Question: Give a one-sentence summary of this figure.
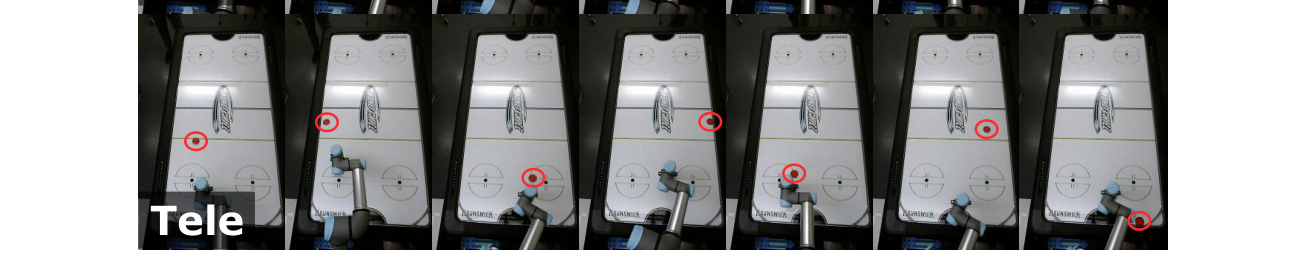
Answer: Execution rollouts on the UR5 air hockey setup for policies trained with behavior cloning, IQL with the touching loss, and human teleoperation demonstrations. Notice that even though humans are trying to achieve multiple bounces, they often hit the puck too erratically to effectively return, so demonstrations can vary significantly in skill, even after cleaning human failure modes.